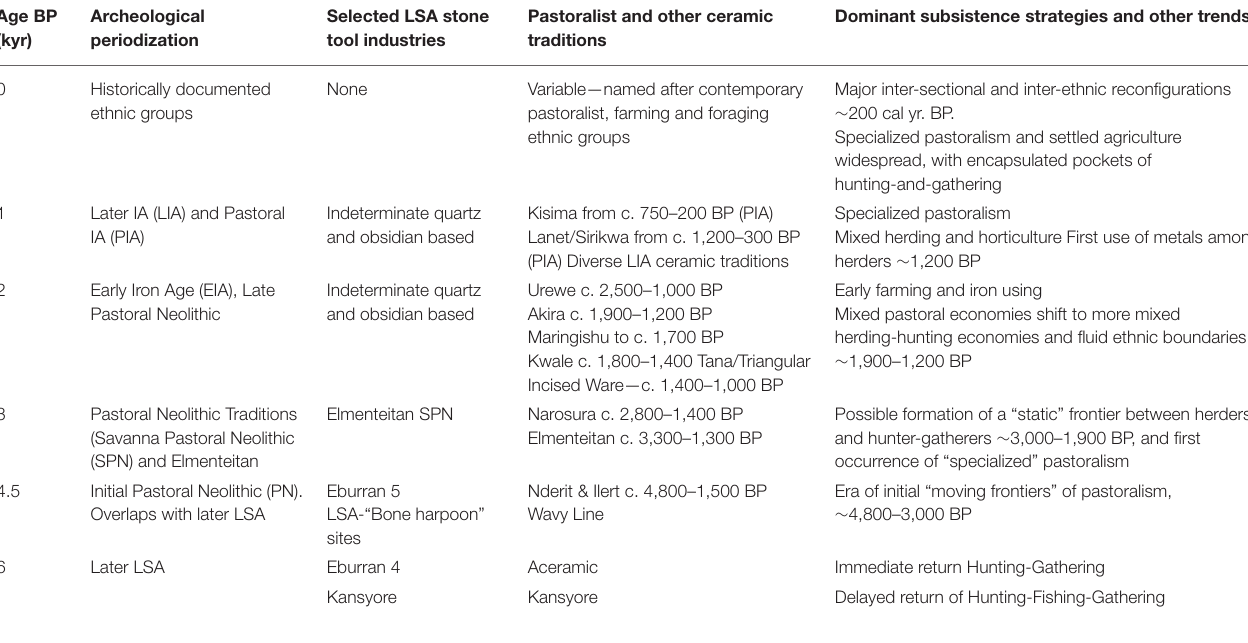
TABLE 4 | Outline chronology of different archeological periods and material traditions in eastern Africa (after Lane, 2013). Age BP